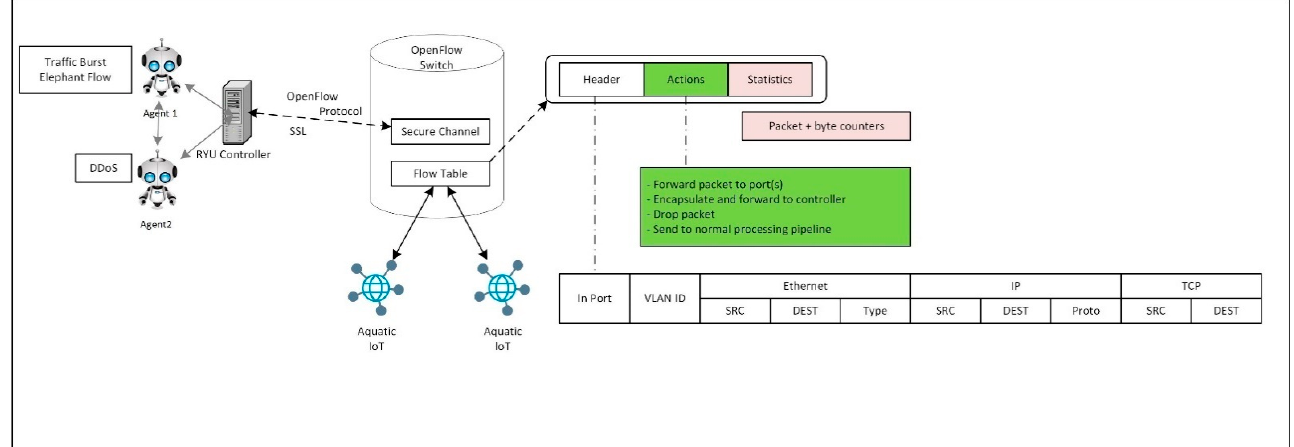
Figure 6. Proposed concept—OpenFlow switches.